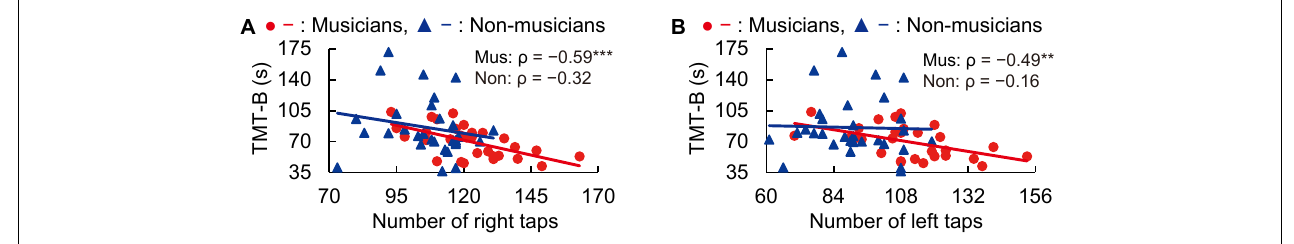
FIGURE 2 | Correlation between tapping and TMT-B. In musicians, the numbers of right (A) and left (B) tapping (in 20 s) were negatively correlated with the time to complete the TMT-B. By contrast, these correlations with tapping were not statistically significant in non-musicians. ** P < 0.01, *** P < 0.001, Mus, musicians; Non, non-musicians; TMT, trail making